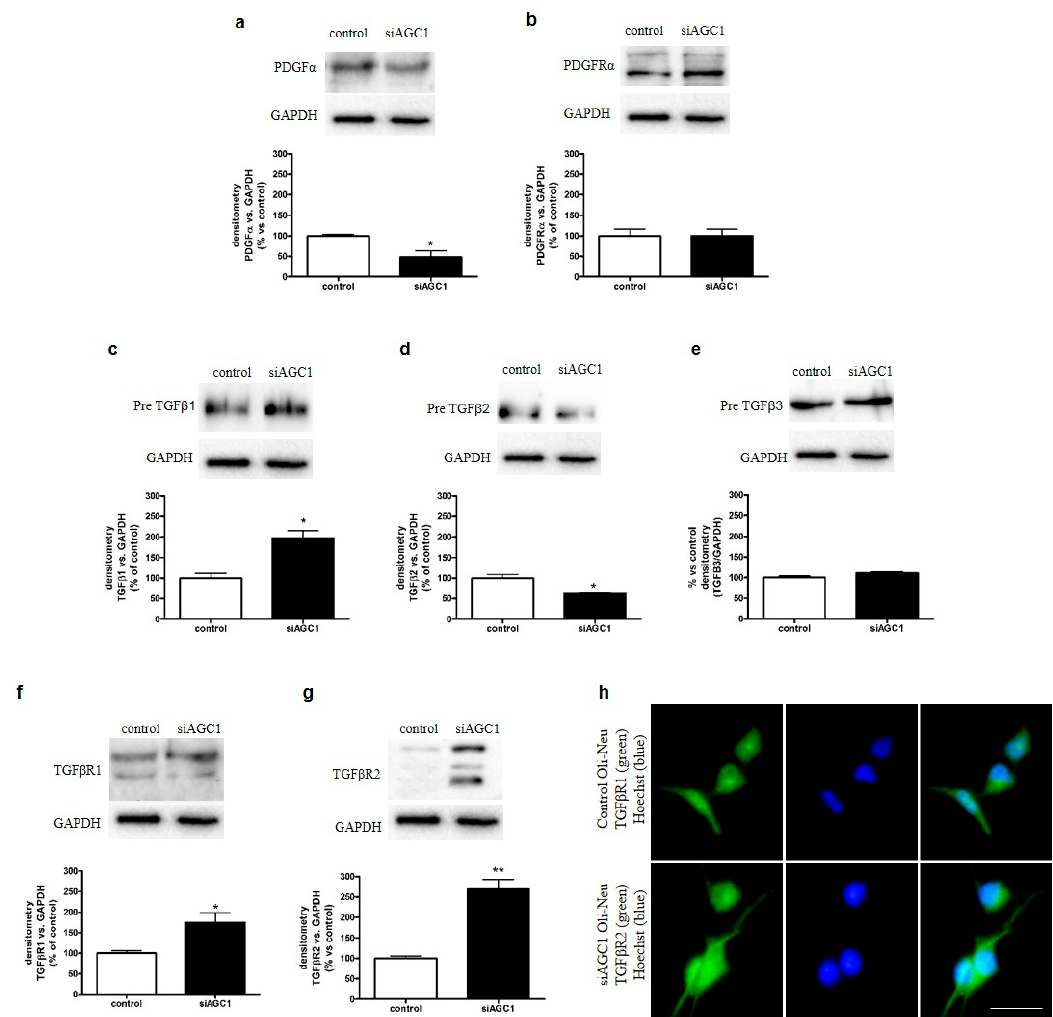
Figure 3. Dysregulation of Platelet-Derived Growth Factor α (PDGF α ) and Transforming Growth Factor β (TGF β ) pathways in AGC1-silenced Oli-Neu cells. Western blot analysis and relative densitometries of PDGF α ( a ), PDGF α R ( b ), TGF β 1 ( c ), TGF β 2 ( d ), TGF β 3 ( e ), TGF β R1 ( f ) and TGF β R2 ( g ) expression in control and siAGC1 Oli-Neu cells. Densitometry is the ratio between the expression level of each protein and GAPDH as reference loading control and is expressed as percentage vs. control Oli-Neu cells. ( h ) Immunofluorescence staining of TGF β R1 in control and siAGC1 Oli-Neu cells (nuclei were labelled with Hoechst). Scale bar: 50 μ m. Values are the mean ± SE of 3 independent experiments performed in triplicate, * p < 0.05, ** p < 0.01, compared to control Oli-Neu cells, Student’s t -test.